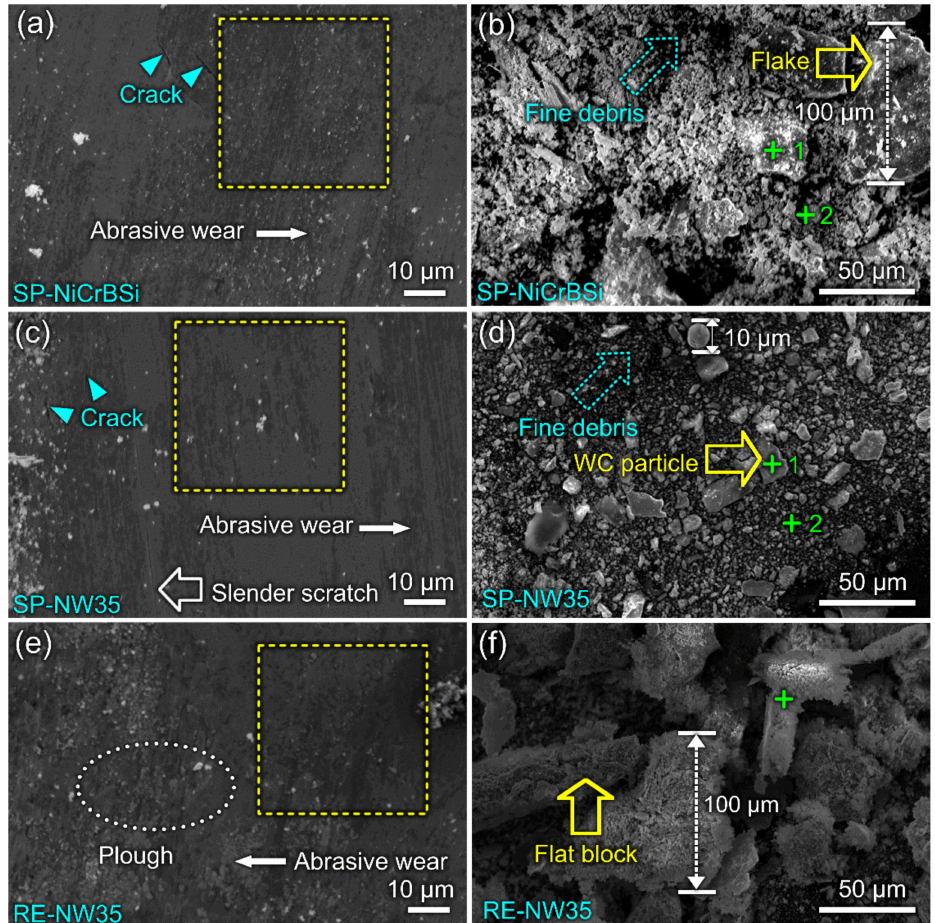
Figure 7. SEM images of worn surfaces ( a , c , e ) and debris ( b , d , f ) of SP-NiCrBSi, SP-NW35 and RE-NW35 coatings after tribology tests at 600 ◦